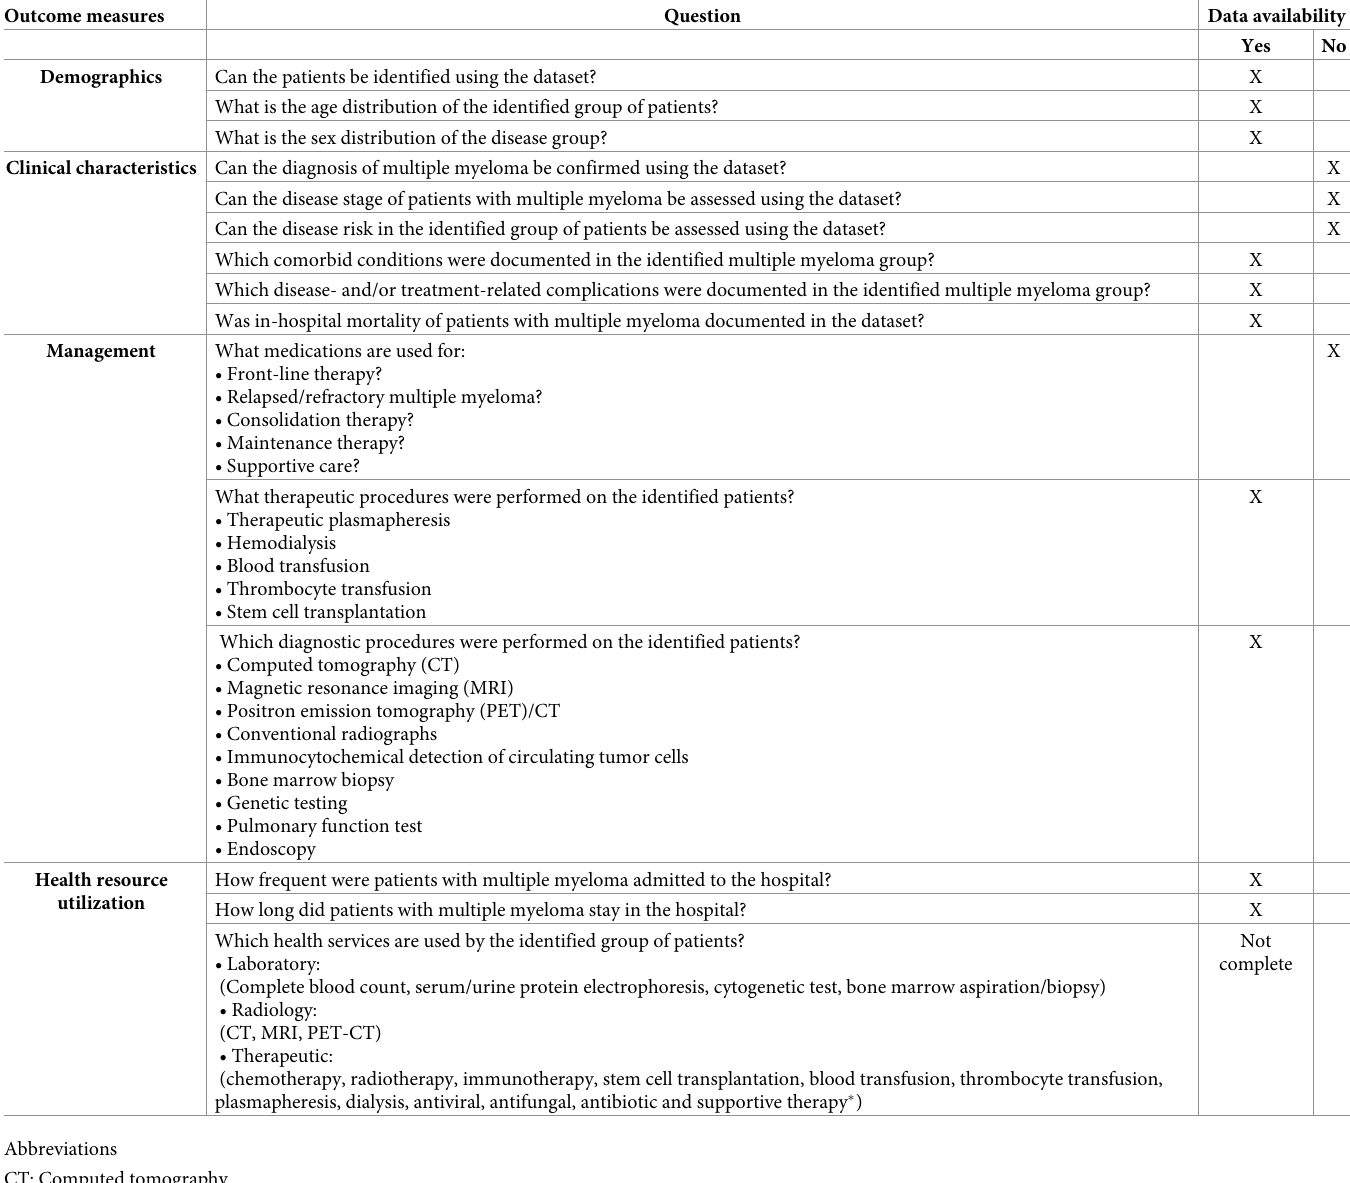
Table 1. Data completeness evaluation tool. Outcome